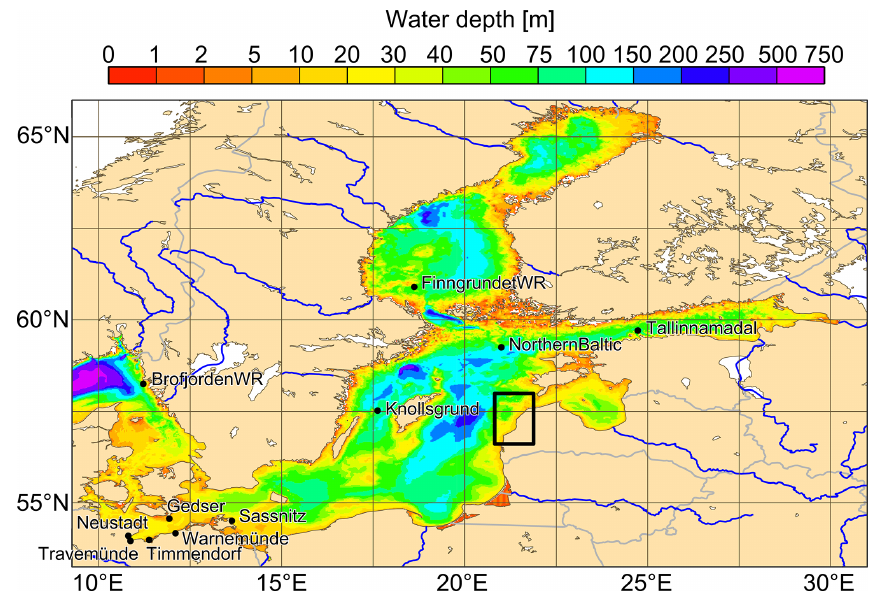
Figure 2. Bathymetry [m] of the 1 nautical mile WAVEWATCH III ® set-up. Black dots show stations for the validation of water level and significant wave height. The black rectangle shows the subregion for plots of the transport simulation